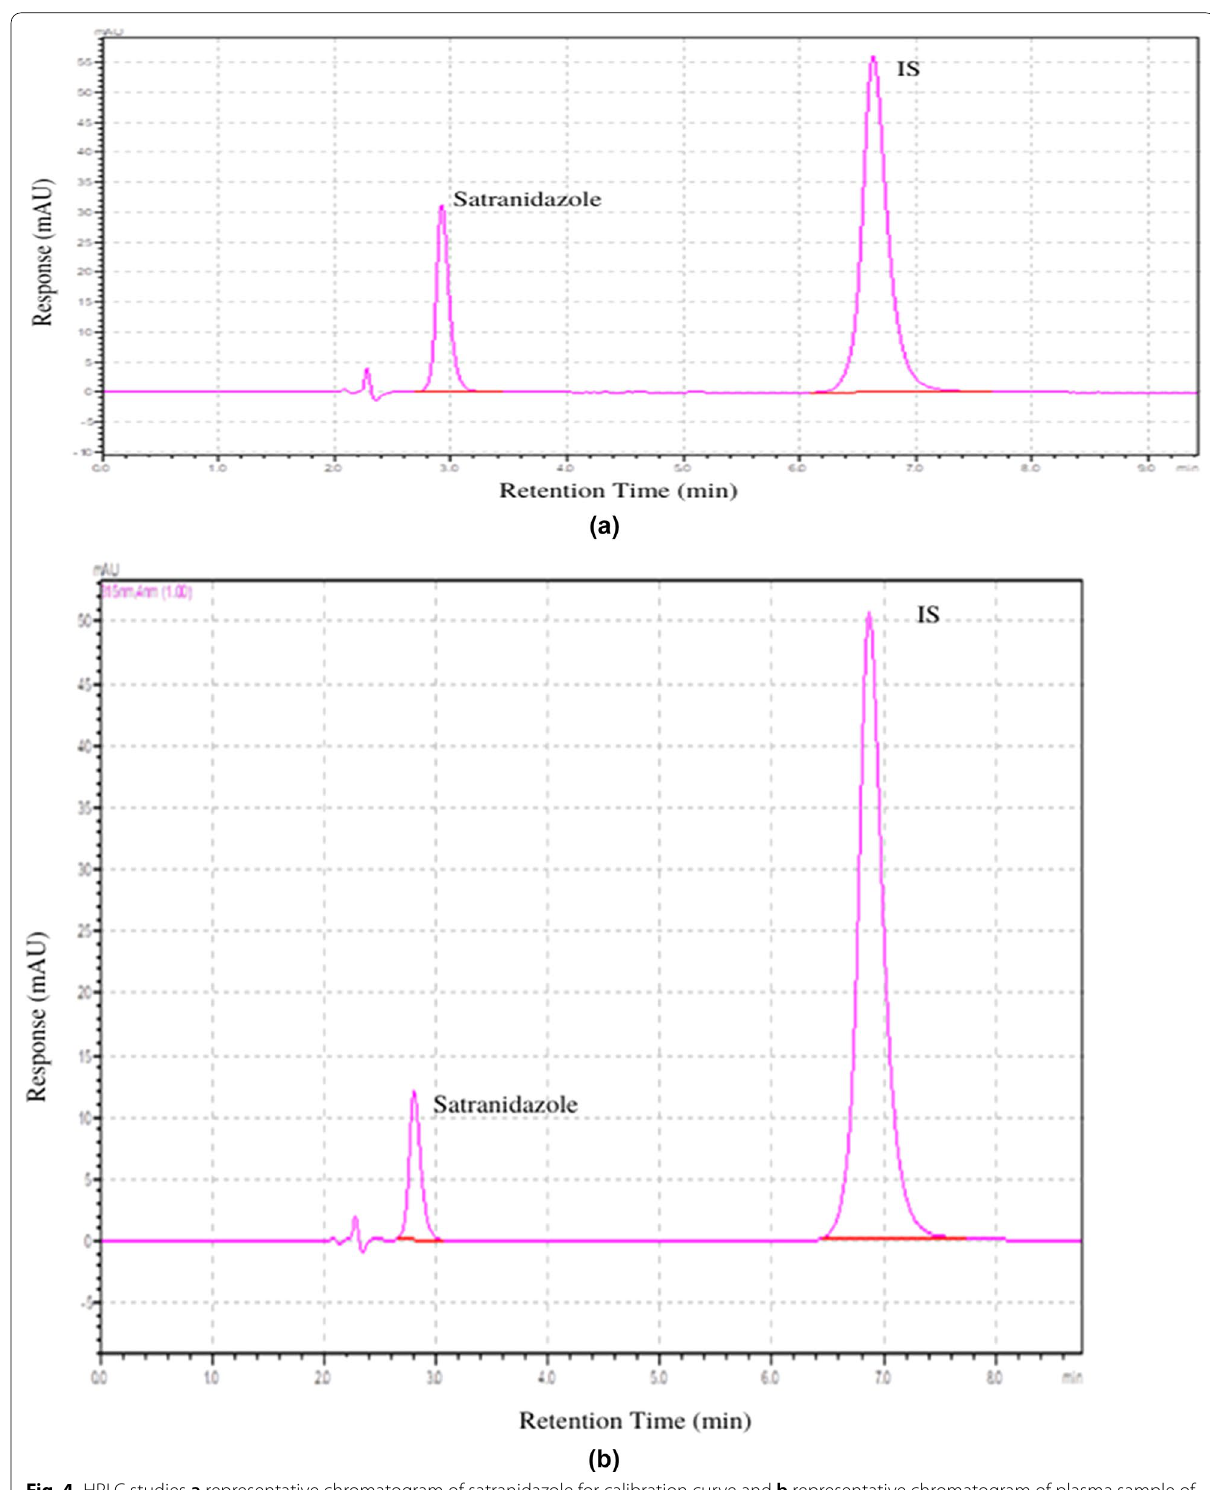
Fig. 4 HPLC studies a representative chromatogram of satranidazole for calibration curve and b representative chromatogram of plasma sample of rat administered with satranidazole. * IS International standard